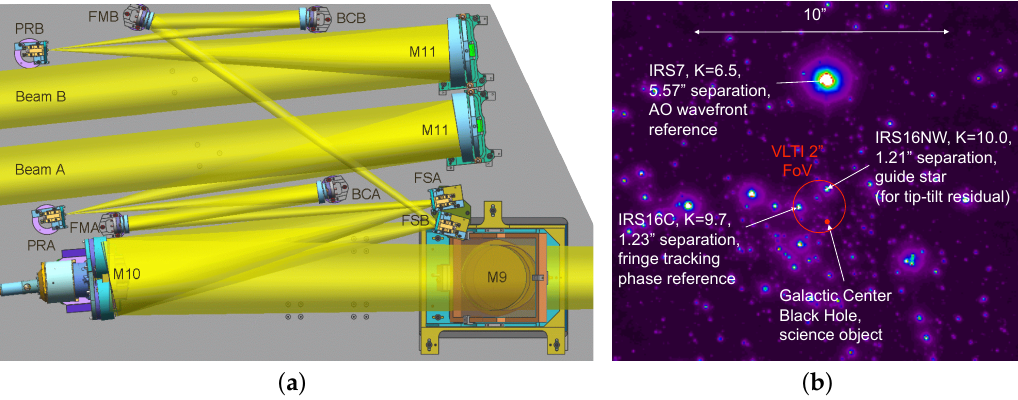
Figure 2. STS optical layout and on-sky set-up for GC observations with GRAVITY. See text for details. ( a ) Seen perpendicular to the image plane, light from the telescope is reflected on the dichroic beam-splitter M9 towards two mirrors labeled M10. The star separator (STS) unit uses two field select mirrors labeled FSA and FSB to pick the light of two objects A and B, focused on the M10 pair. FSA and FSB are able to scan M10. The light of the two selected objects is then relayed via folding mirrors (labeled FMA and FMB) towards the output beams A and B. Before, however, the beams are compressed via two elliptical mirrors labeled BCA and BCB, and then forwarded via the pupil re-imagers PRA and PRB. Each output beam contains a field of view of about 2 (cid:48)(cid:48) × 2 (cid:48)(cid:48) . Image: ESO; ( b ) STS set-up for GC observations with GRAVITY. Light from the infrared source IRS7 is transmitted via the STS beam B to the CIAO wavefront sensor. Light from inside the VLTI 2 (cid:48)(cid:48) field of view (red circle) is transmitted via the STS beam A to to GRAVITY